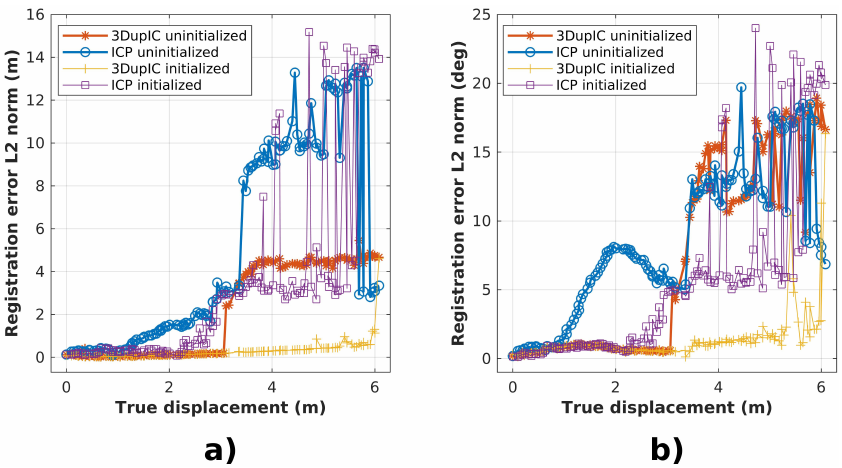
Figure 6. Results of the short trajectory experiment, to evaluate the impact of scan distance on the registration accuracy. The horizontal axis represents the true distance between scan acquisition poses. In the vertical axis, ( a ) displays the position error and ( b ) shows the orientation